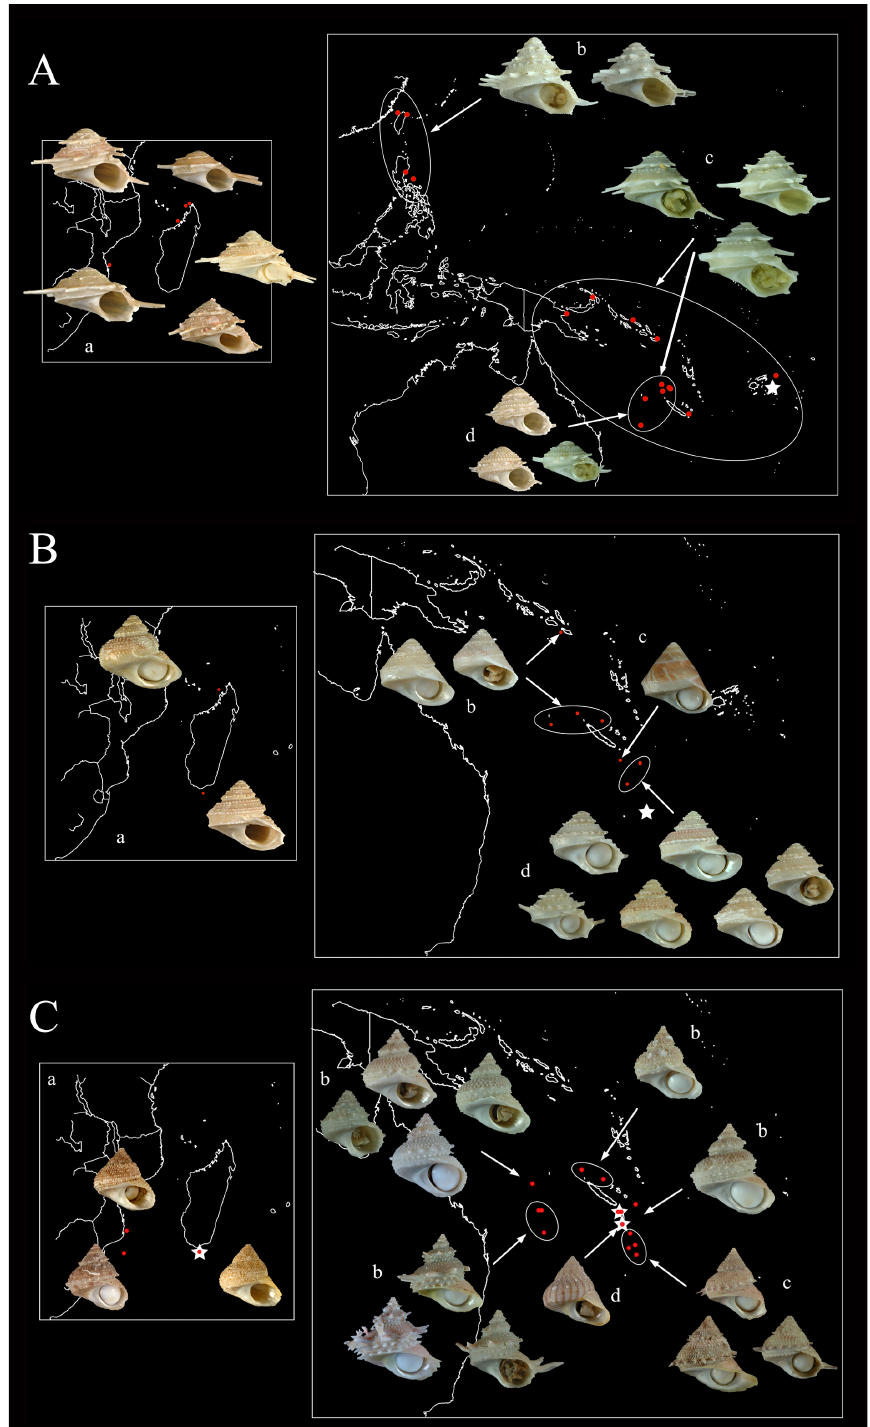
Fig. 3. A . a , Bolma henica madagascarensis (Indian Ocean); b , Bo. henica abyssorum ; c , Bo. henica henica , with type locality represented by a white star (Fiji Island, Southwest Pacific); d , Bo. cf. minutiradiosa . B. a–d , distinct shell morphs found in Bo. recens, with type locality represented by a white star (Kiwi seamount, Three Kings Ridge). C. a , Bo. mainbaza , with type locality (South Madagascar); b , Bo. pseudobathyraphis , with type locality (South New Caledonia); c , Bo. millegranosa ; d , Bo. opaoana with type locality (South New Caledonia, Crypthélia